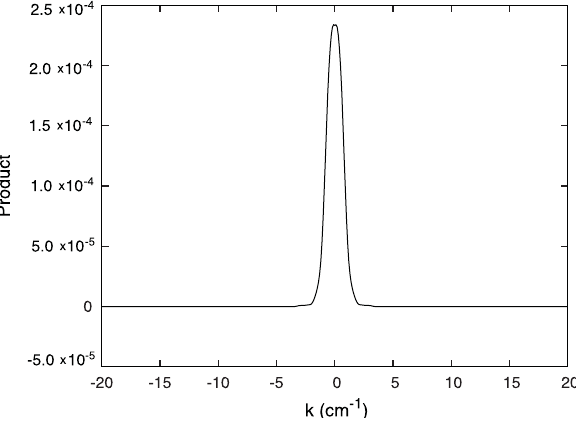
~ ð R; k Þ =I 0 b appearing in (22), as m;s m